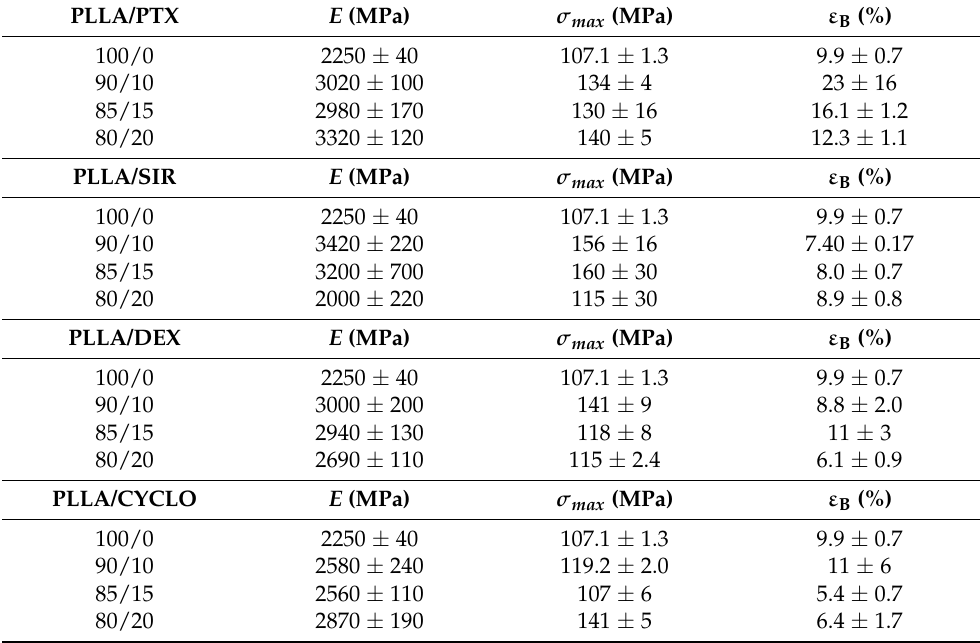
Table 4. Mechanical properties (elastic modulus ( E ), tensile strength ( σ max ), elongation at break ( ε B )), determined from uniaxial tensile tests of PLLA/drug spray coated films in different drug ratios (90/10, 85/15 and 80/20 w / w